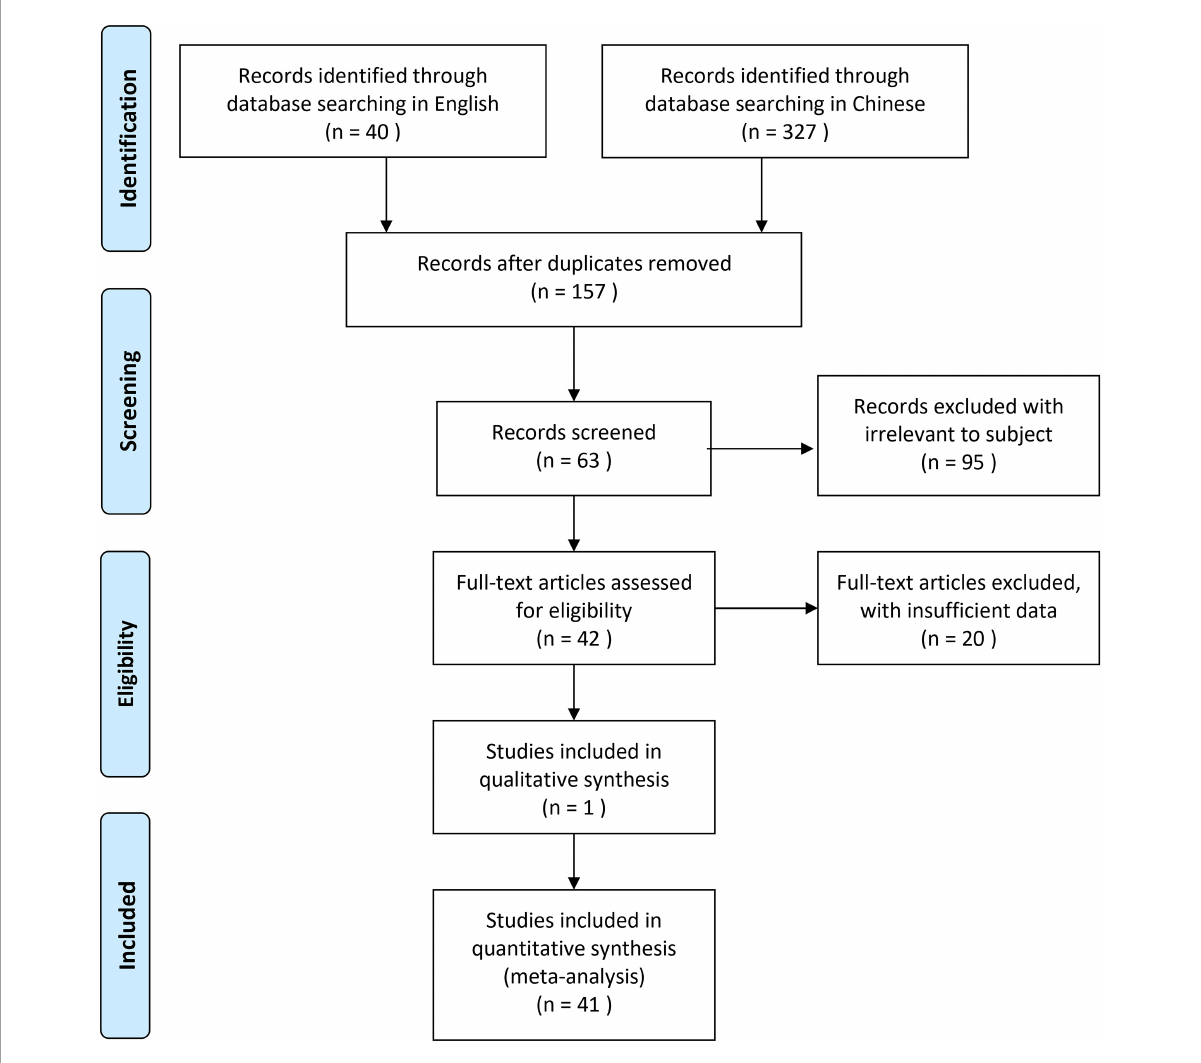
FIGURE1 The methodological flowchart of PRISMA for the selection of the included studies in this